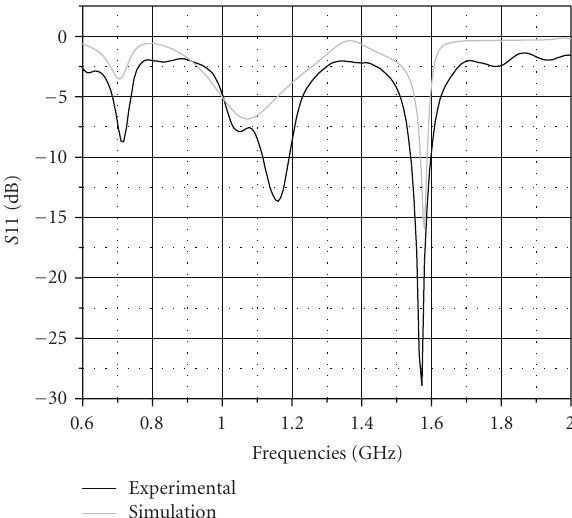
Figure 5: Pictures of GPS antenna, top and bottom sides.